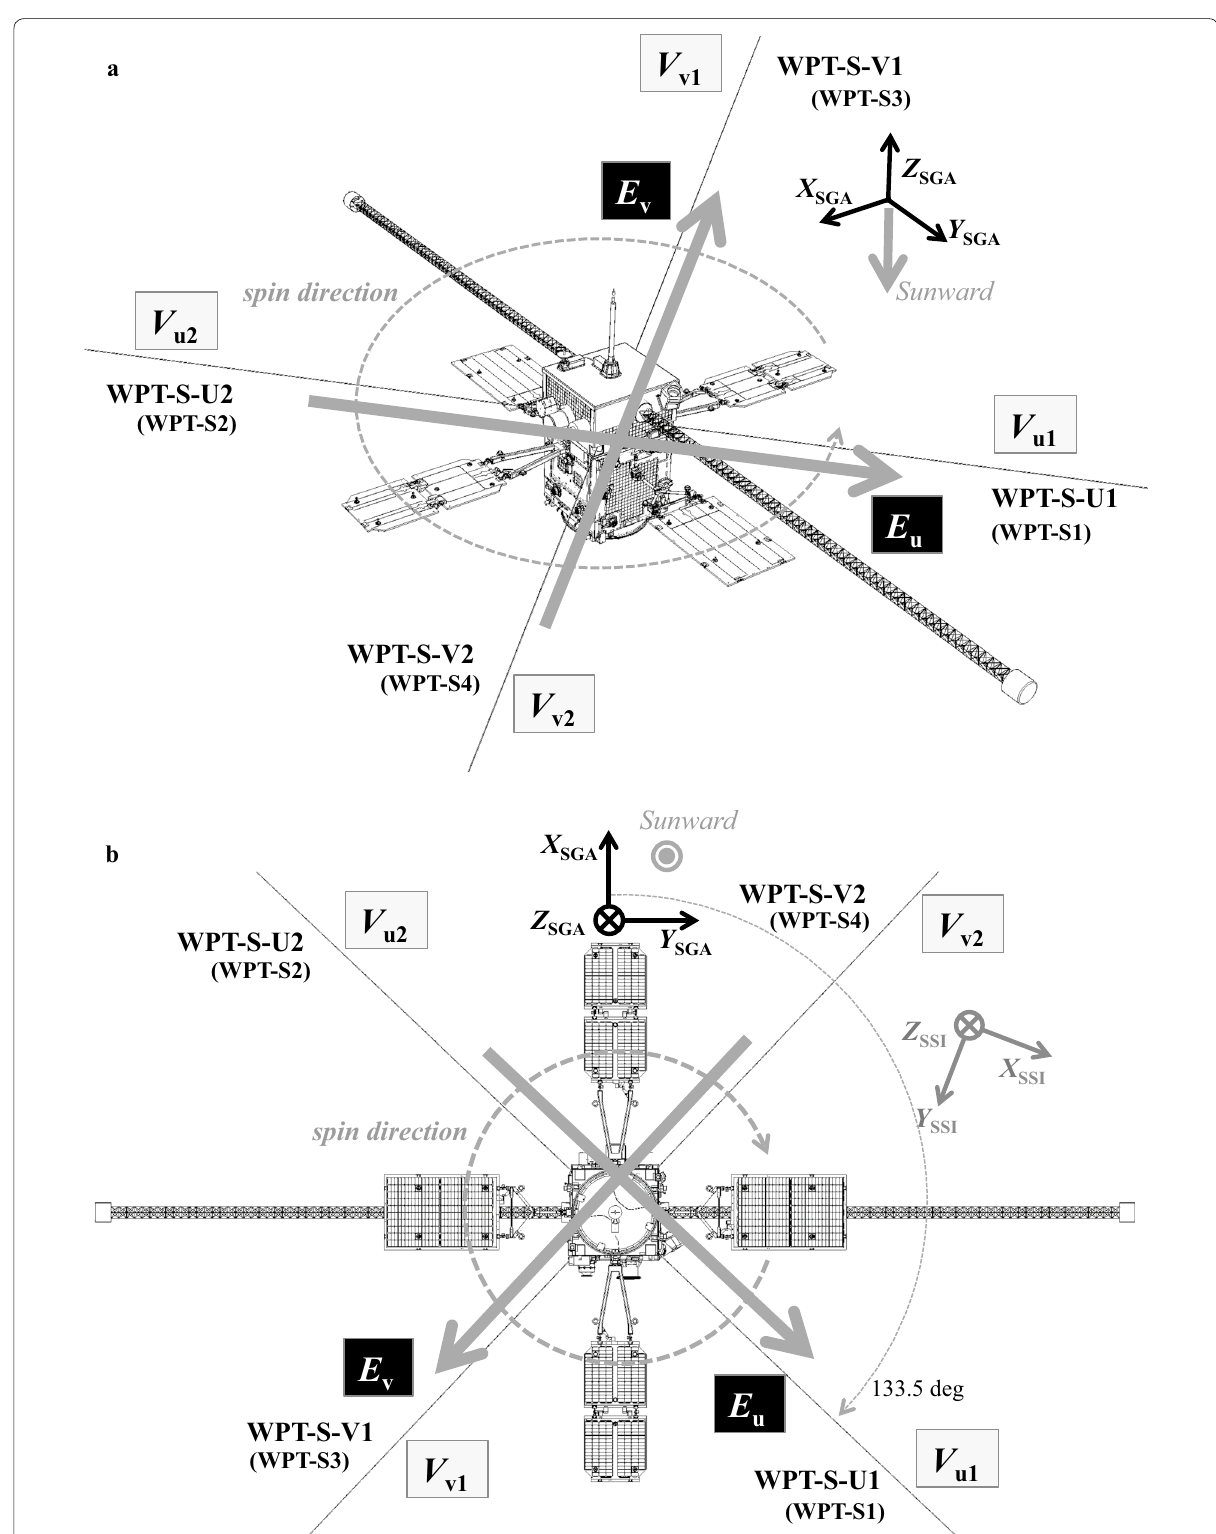
Fig. 2 ERG spacecraft and PWE WPT-S sensors. a External view and b the view from the solar direction (Z). The definitions of two spacecraft coordi- nates, SGA and SSI, are indicated. The direction of the spacecraft spin rotation (usual: ~ 1/8 Hz) is also shown. [Modified from Fig. 1 of Kasahara et al.